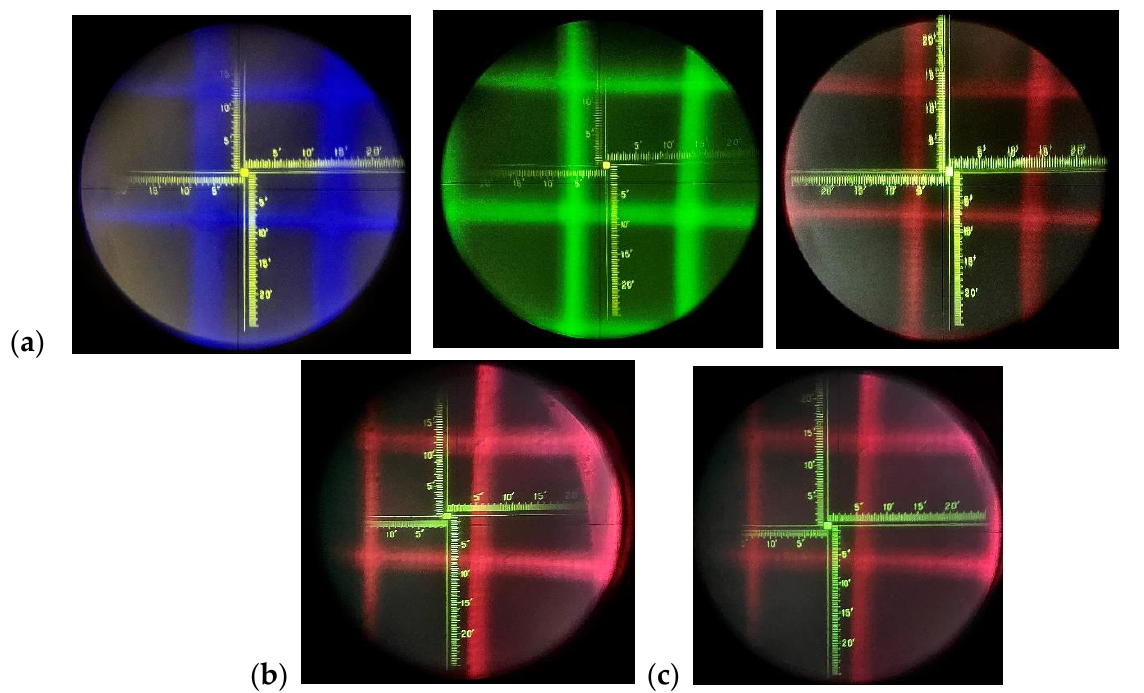
Figure 14. ( a ) Test image observed against the background of the collimator grid. ( b ) Wavelength shift is 0.5 angular minutes. ( c ) There is no wavelength shift. shift is 0.5 angular minutes. ( c ) There is no wavelength